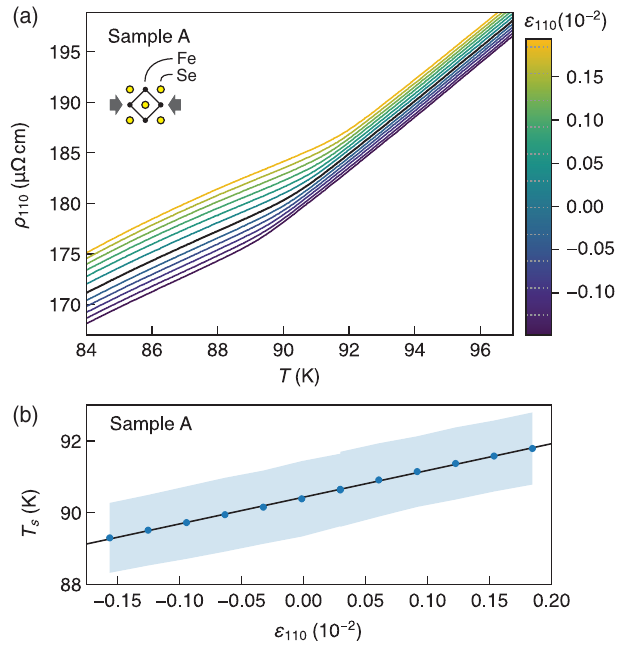
FIG. 2. The effect of transverse strain. (a) ρ 110 ð T Þ , the resis- tivity along the [110] direction, for sample A at various applied strains ε 110 . The principal axes of the nematicity in FeSe are the h 100 i axes, so this strain is a transverse field to the nematicity. Inset: schematic of the strain axis. (b) T versus ε 110 for this s is identified as the maximum in d 2 ρ 110 =dT 2 . The sample. T s shaded region is a measure of the width of the transition: it is where d 2 ρ =dT 2 exceeds half its maximum value. The line is a fit.